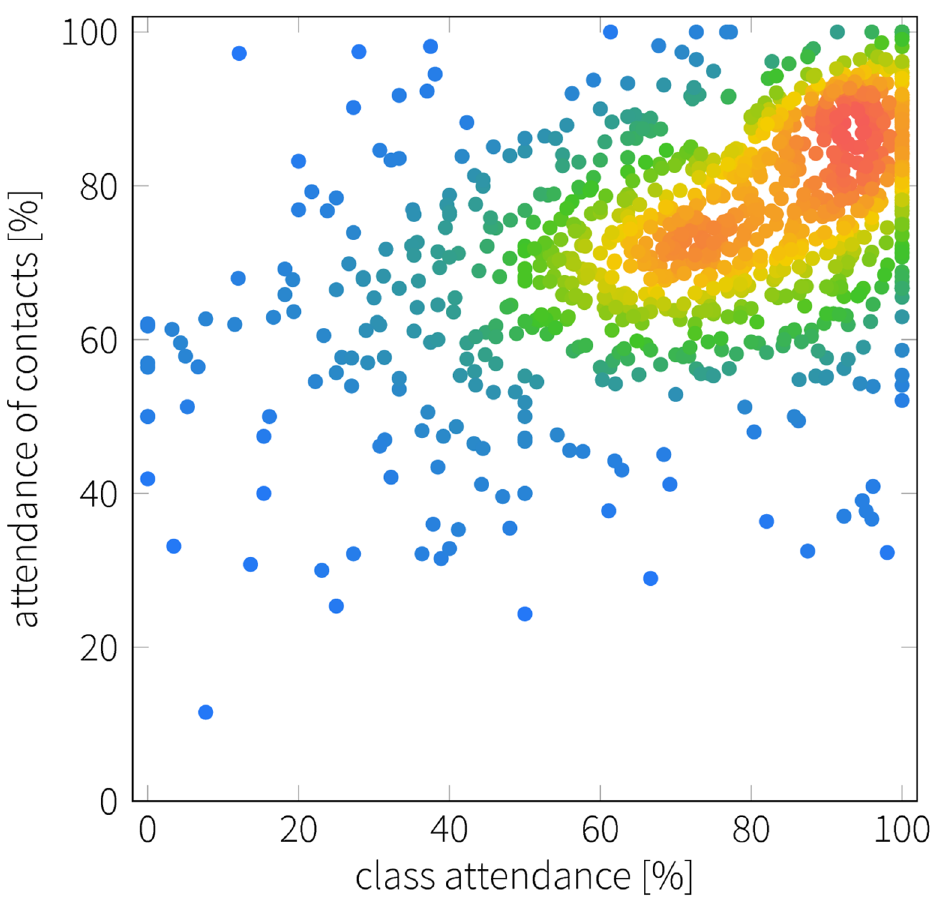
Fig 6. Correlation between own and peers’ attendance. Scatter plot that shows student’s own attendance vs mean attendance amongcontacts (inferred from text messages) at the course level. Color represents the relativedensity of data